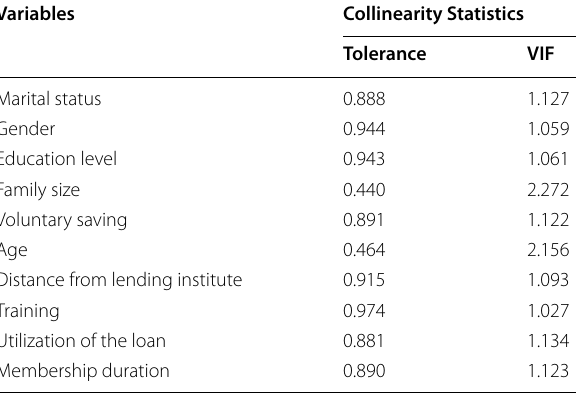
Table 9 Multicollinearity test among explanatory variables.